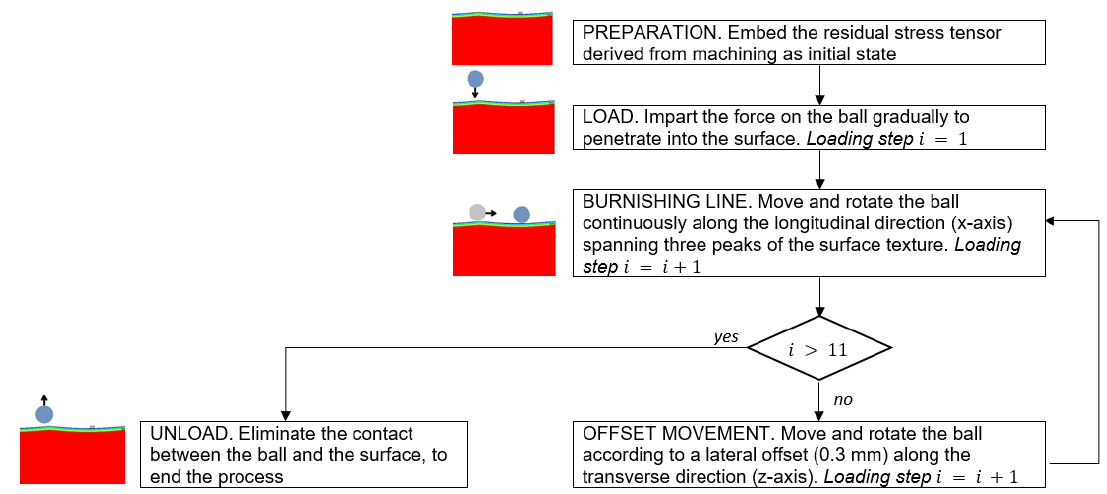
Figure 3. Flow diagram showing the simulation steps of ball